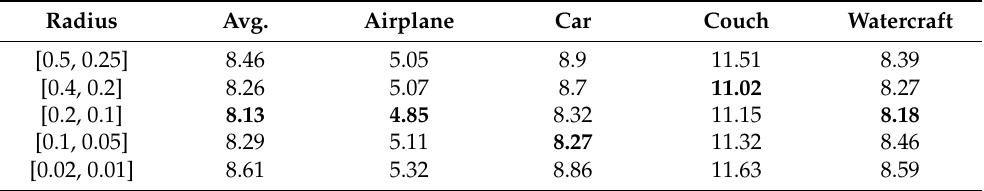
Table 5. Comparison of results for different radii in the sphere neighborhood in terms of per-point chamfer distance (CD) with L1 norm computed on 16,384 points and multiplied by 10 3 . The best results are highlighted in bold (lower is